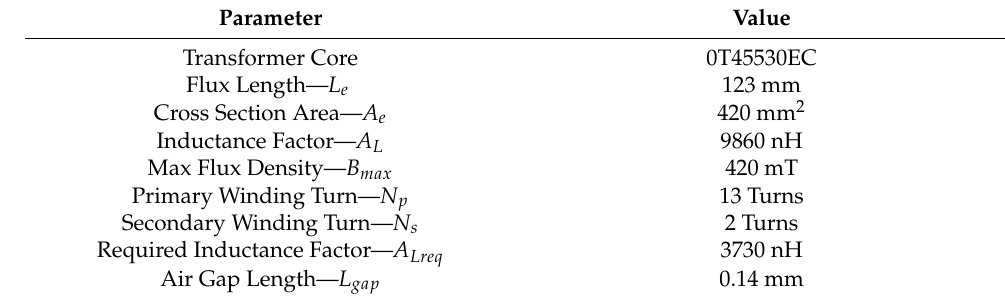
Table 2. Calculated parameters of designed LLC resonant converter transformer.